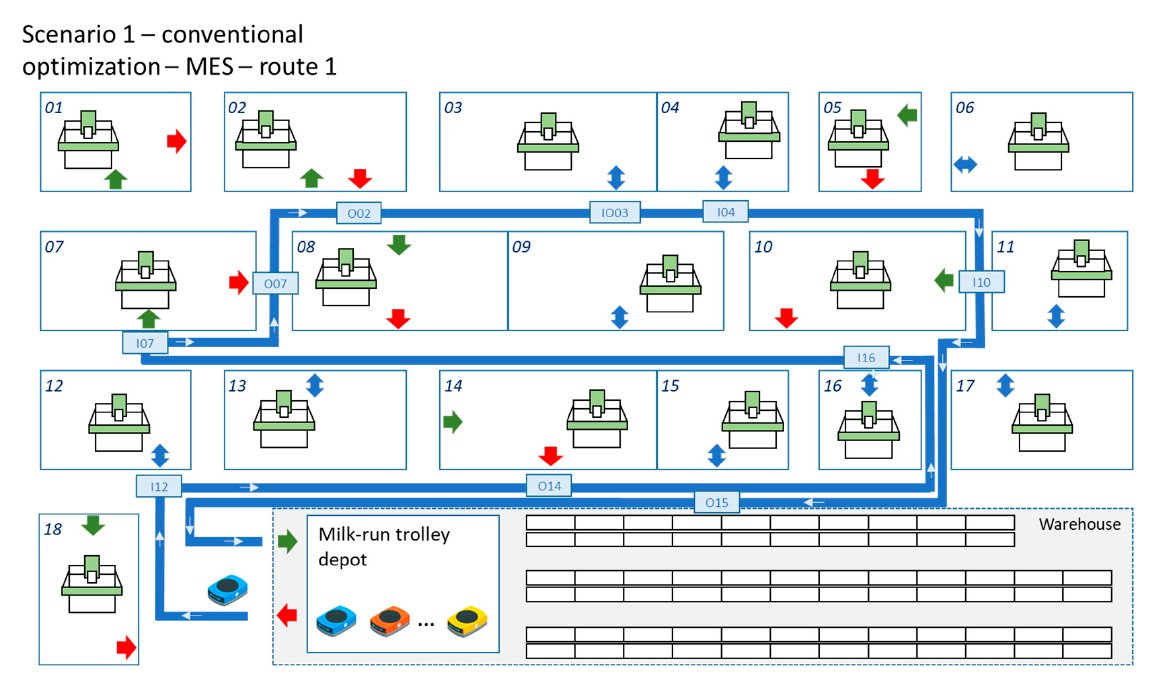
Figure 3. The first route of the conventional milk-run-based in-plant supply including MES data- based supply demands. Table 3. Numerical results of the scheduling of predefined specific in-plant material supply opera- tions performed by the milk-run trolley within route 1.